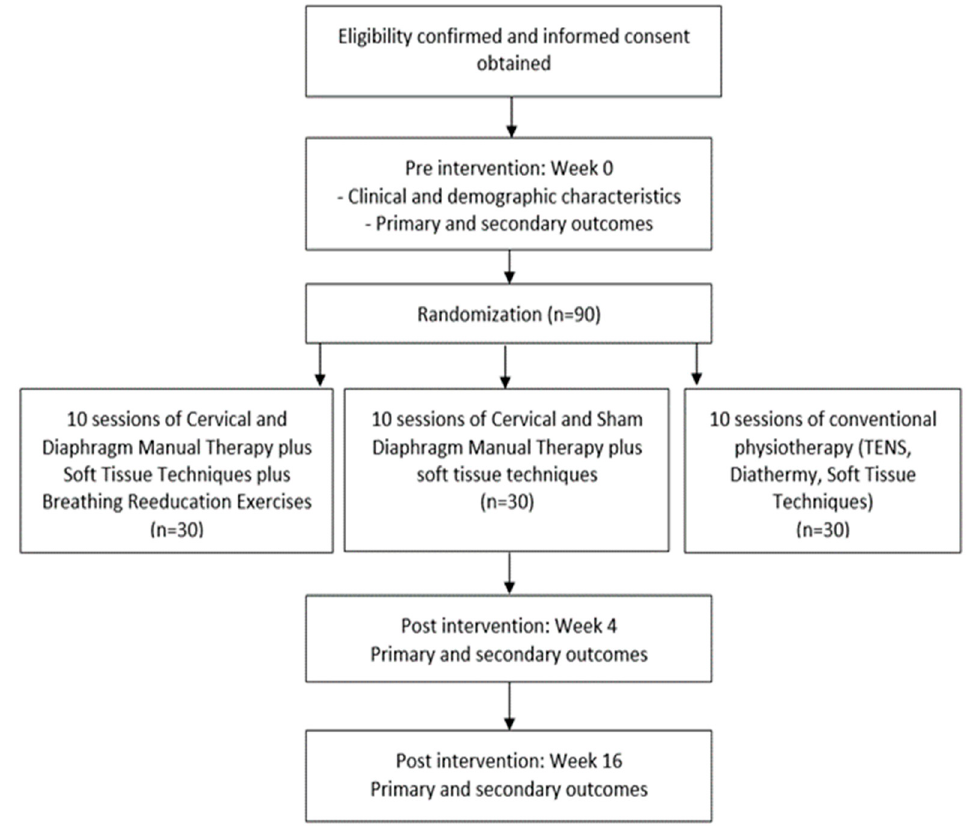
Figure 2. Design of the trial.